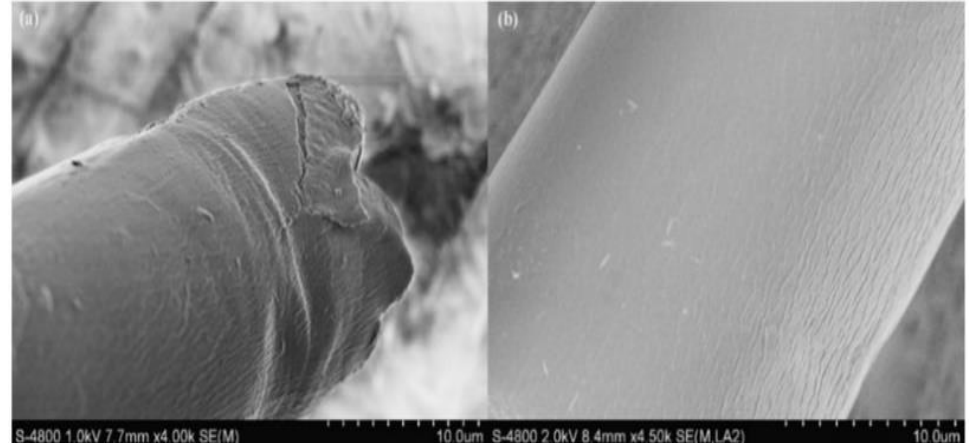
Figure 10. SEM images of ( a ) raw and ( b ) sodium chlorite treated KF [52]. Reprinted from Chemical Engineering Journal, 184, Liu, Y., Wang, J., Zheng, Y., & Wang, A., Adsorption of methylene blue by kapok fiber treated by sodium chlorite optimized with response surface methodology, 248 – 255, Copyright (2012), with permission from Elsevier.